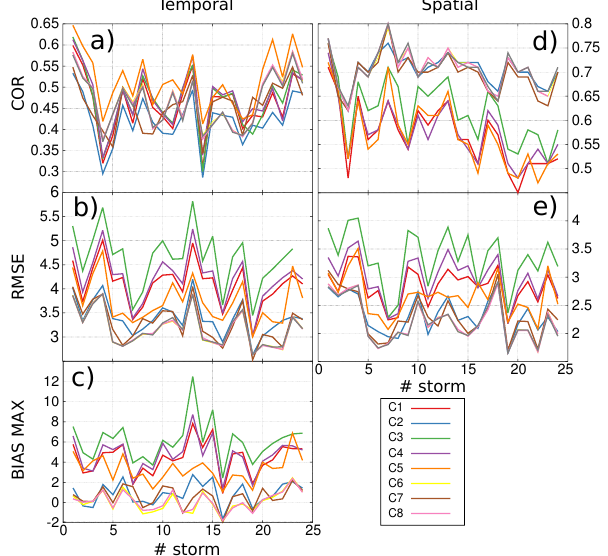
Figure 7. Model performance for the comparison of observed and simulated wind speed across the 24 storms defined in Table 1. Each coloured line corresponds to a model set-up. Correlation (a and d) , RMSE (b and e) and bias in the maximum wind speed (c) are shown in the temporal (a , b and c) and spatial (d and e) domains, respec- tively. The spatial values correspond directly to the diamonds in Fig. 5, whereas the time statistics show the median value; this is the centre of the boxplots in the same figure.